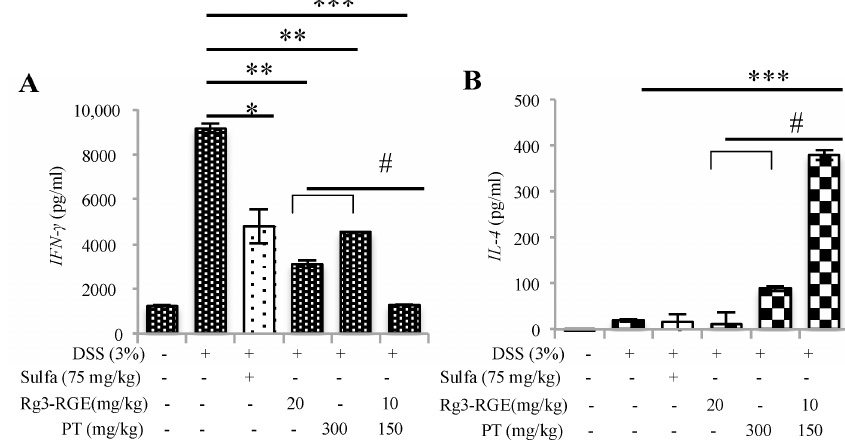
Figure 9. E ff ects of Rg3-RGE + PT on lymphokine secretion. ( A ) Splenocyte supernatant levels of IFN- γ Figure 9. Effects of Rg3 ‐ RGE + PT on lymphokine secretion. ( A ) Splenocyte supernatant levels of IFN ‐ in the Sulfasalazine, Rg3-RGE, PT and Rg3-RGE + PT groups as determined by ELISA. ( B ) Splenocyte γ in the Sulfasalazine, Rg3 ‐ RGE, PT and Rg3 ‐ RGE + PT groups as determined by ELISA. ( B ) supernatant levels of IL-4 in the Rg3-RGE + PT group as determined by ELISA *** p < 0.001, ** p < 0.05 Splenocyte supernatant levels of IL ‐ 4 in the Rg3 ‐ RGE + PT group as determined by ELISA *** p < 0.001, and * p < 0.01 when compared to the DSS-treated group and # p < 0.01 compared to the inhibition ** p < 0.05 and * p < 0.01 when compared to the DSS ‐ treated group and # p < 0.01 compared to the by only Rg3-RGE or PT. Values in bar graphs represent mean ± SD of four independent experiments. inhibition by only Rg3 ‐ RGE or PT. Values in bar graphs represent mean ± SD of four independent Experiments were conducted within 72 h of experiments. Experiments were conducted within 72 h of termination.